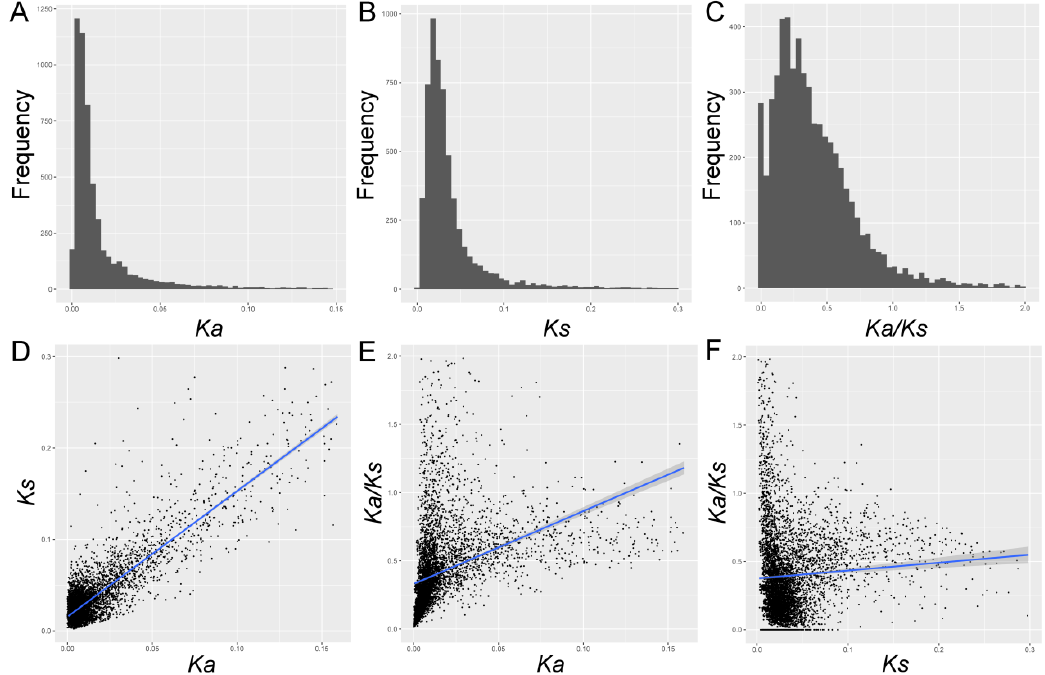
Figure 1. The frequency distributions ( A – C ) and correlation analyses ( D – F ) of Ka, Ks, and Ka/Ks. ( A – C ) The frequency displays of Ka, Ks, and Ka/Ks, respectively. ( D ) The correlation between Ka and Ks. ( E ) The correlation between Ka/Ks and Ka. ( F ) The correlation between Ka/Ks and Ks. The blue line represented the fitted curve, and the shaded part represented the confidence interval.